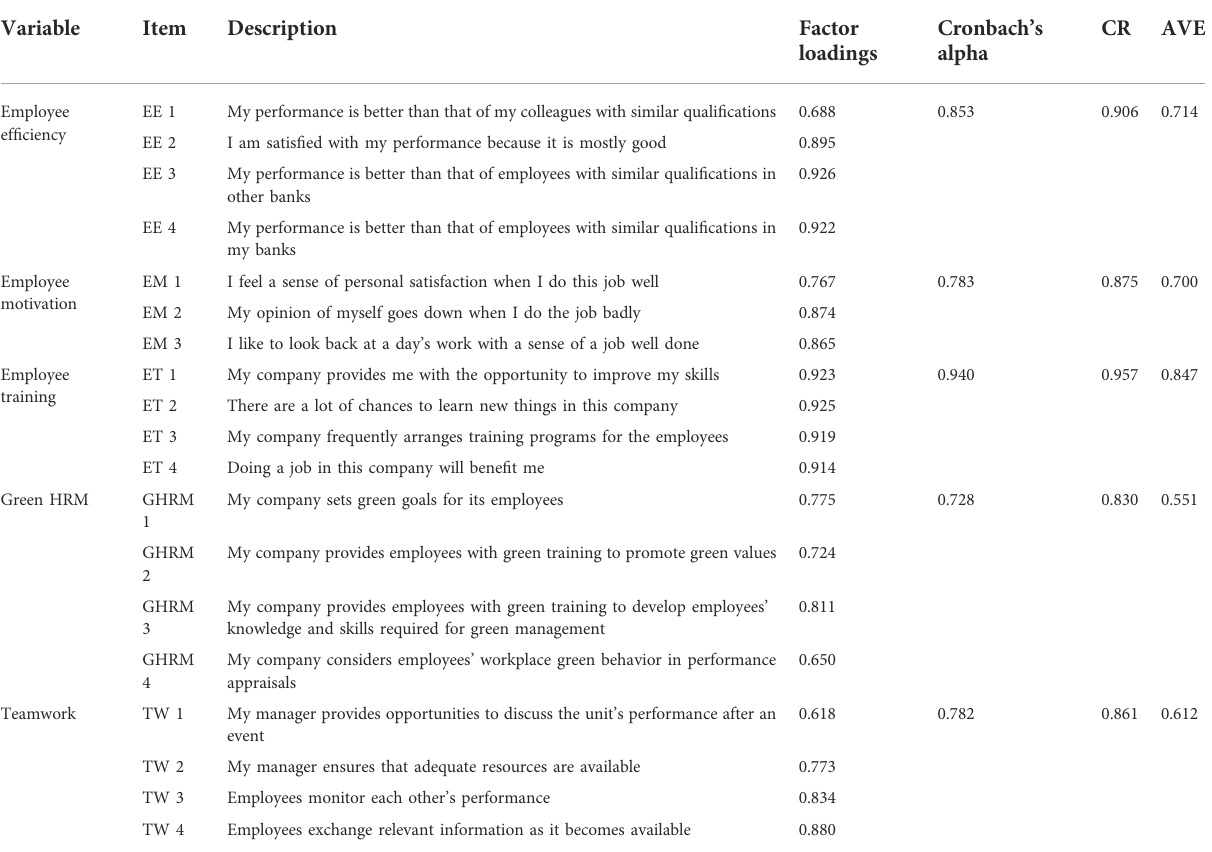
TABLE 1 Factor loadings, Cronbach ’ s alpha, CR, and AVE.